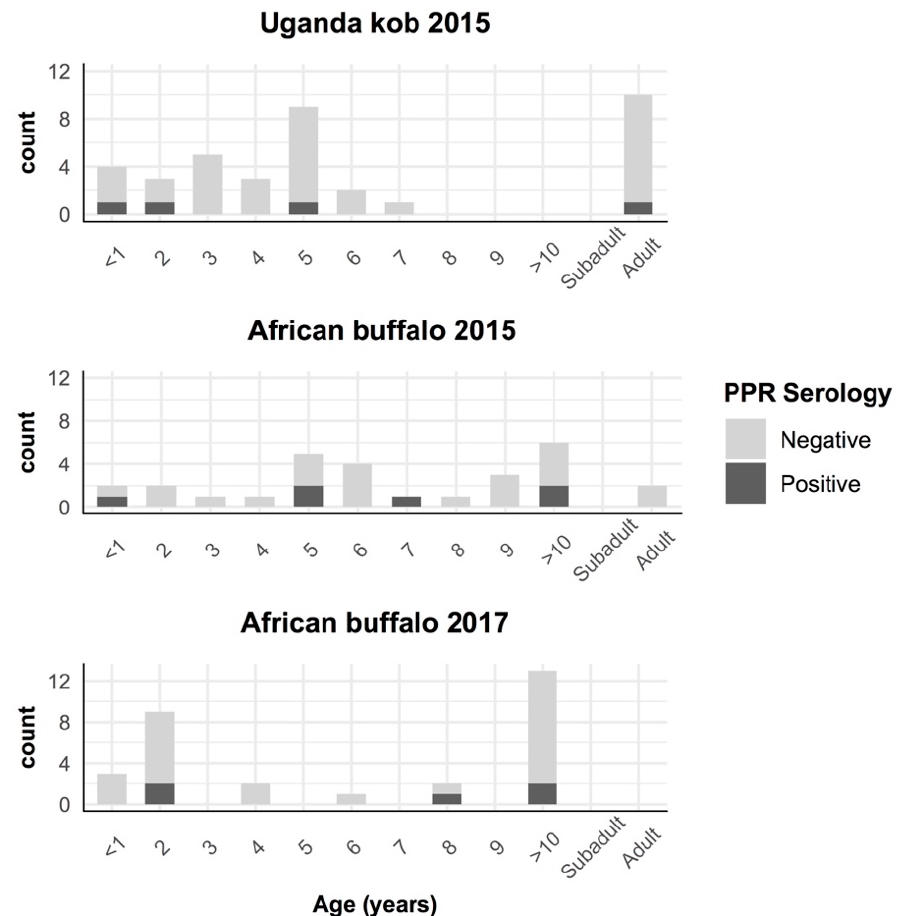
Figure 3. Results of PPRV antibody detection by age in African buffalo and Uganda kob captured in Queen Elizabeth National Park, Uganda. Animals without aging in years are classified as subadult (<3 years) and adult (>3 years).